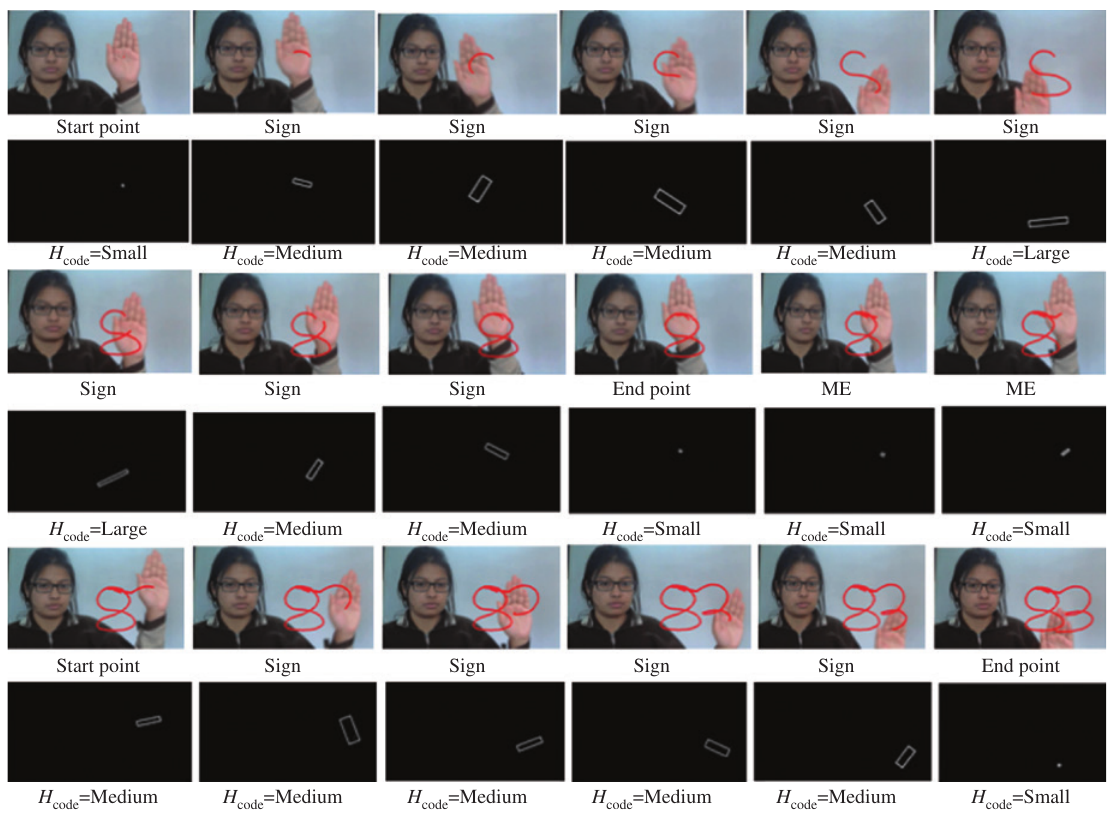
Figure 12: Variation of the Proposed Feature for Modeling ME.